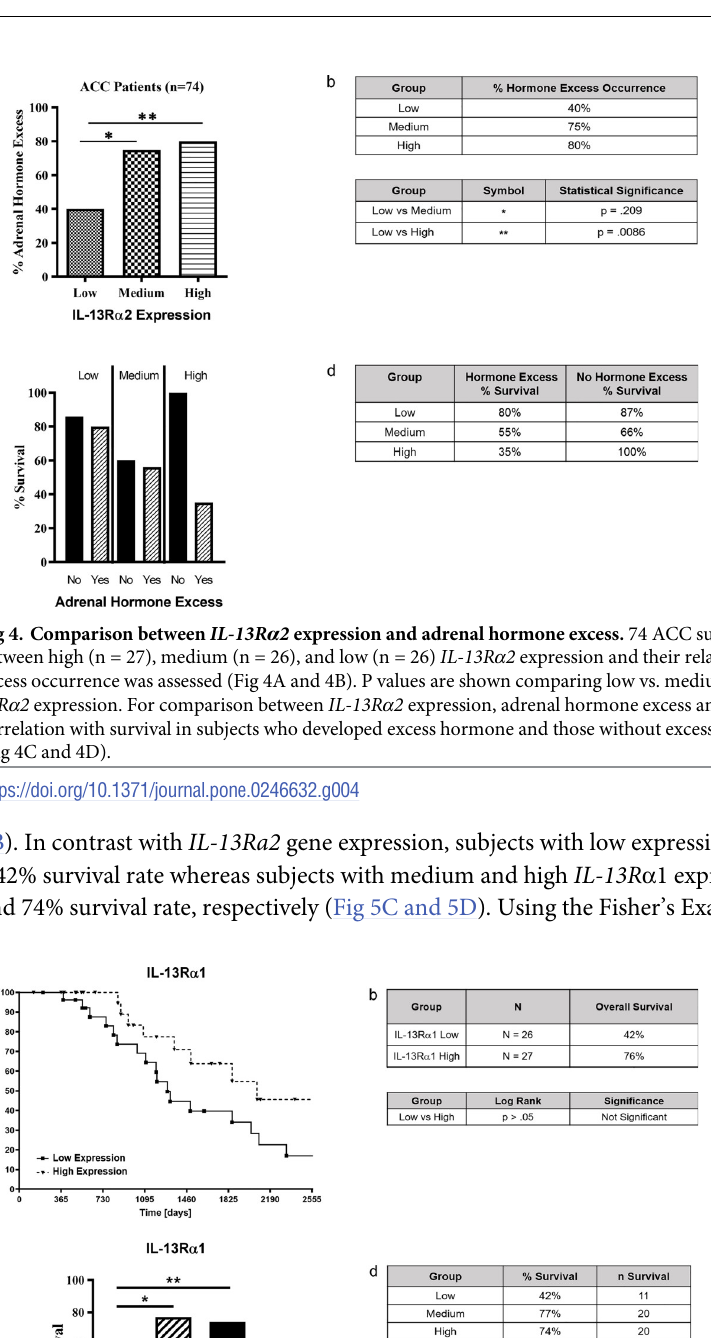
Fig 5. IL-13R α 1 expression and survival analysis of patients with ACC. 79 ACC patients were divided between high (n = 27), medium (n = 26), and low (n = 26) IL-13R α 1 (Fig 5A and 5B) expression and Kaplan-Meier survival analysis was performed to determine survival time over 7-year period. In addition, IL-13R α 1 expression and its relationship with ACC overall survival was assessed (Fig 5C and 5D). Data was analyzed for different IL-13R α 1 expression levels and ACC survival using the Graph Pad Prism software. P values are shown comparing high vs. low expression.